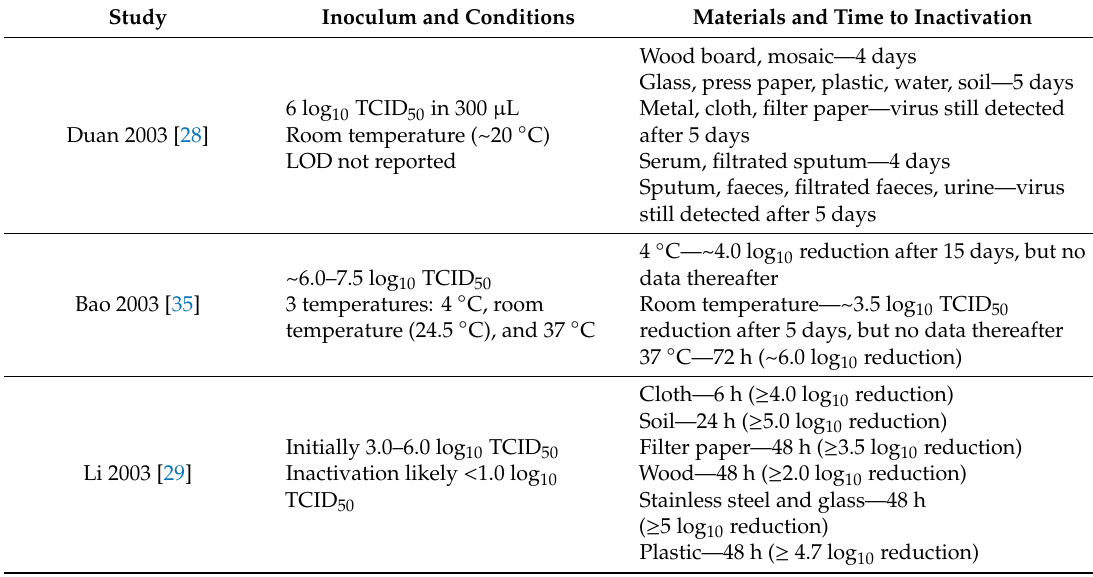
Table 2. Studies reporting on the viability of